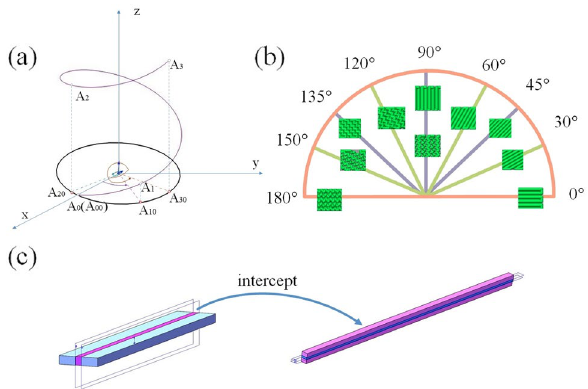
Figure 3. ( a ) Schematic diagram of the self-spiraling fiber; ( b ) different printing angles of FDM; and ( c ) the strain energy density function interception